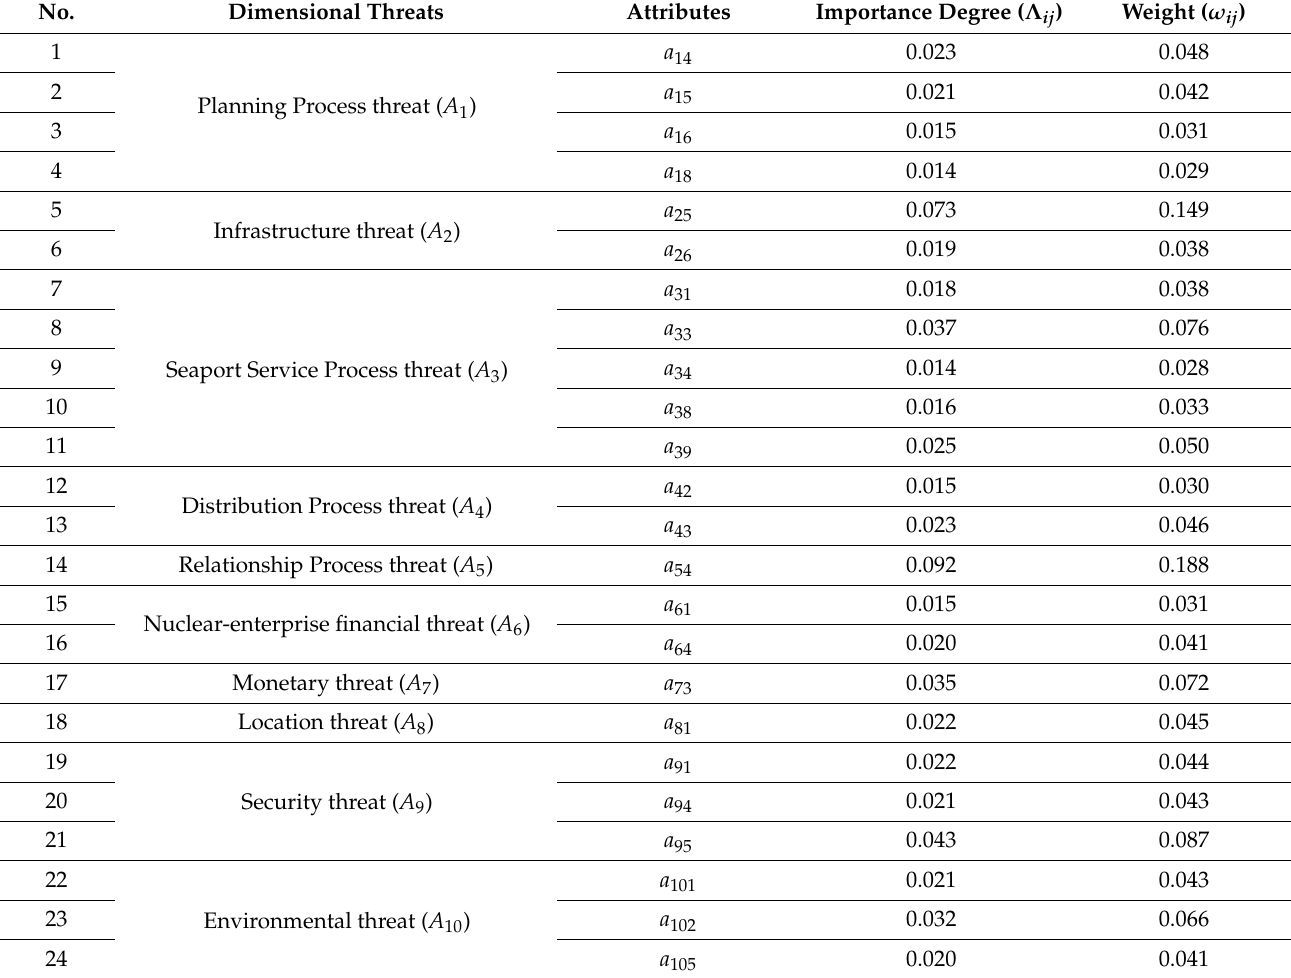
Table 5. RSGA score of the port-centric supply chain risk.